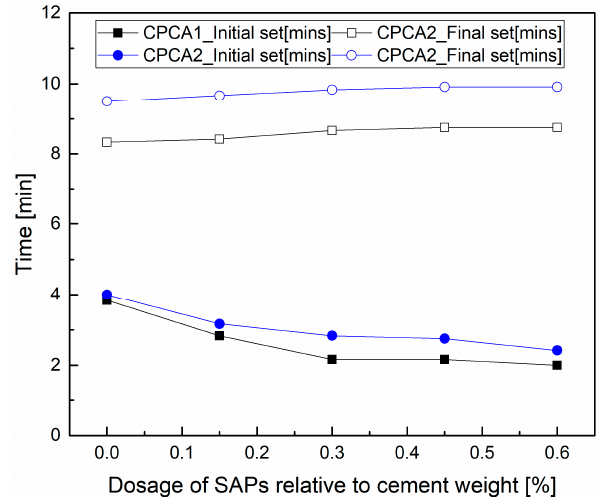
Figure 3. The setting time for the cement paste containing accelerators as a function of the dosage of SAPs.